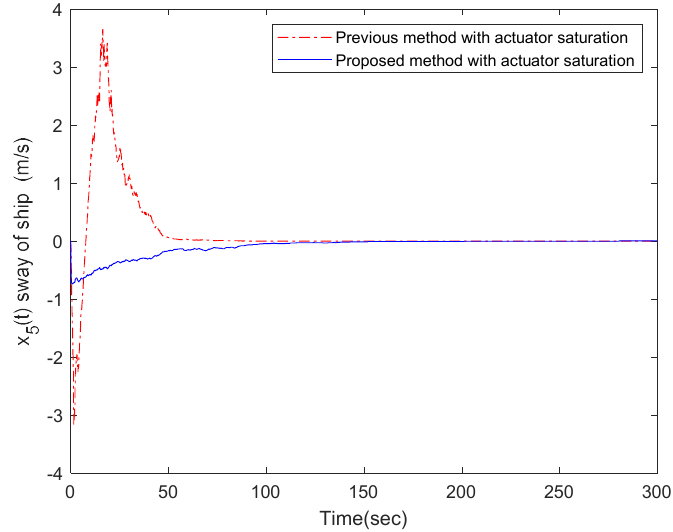
Figure 8. The responses of x 5 ( t ) compared with [29].